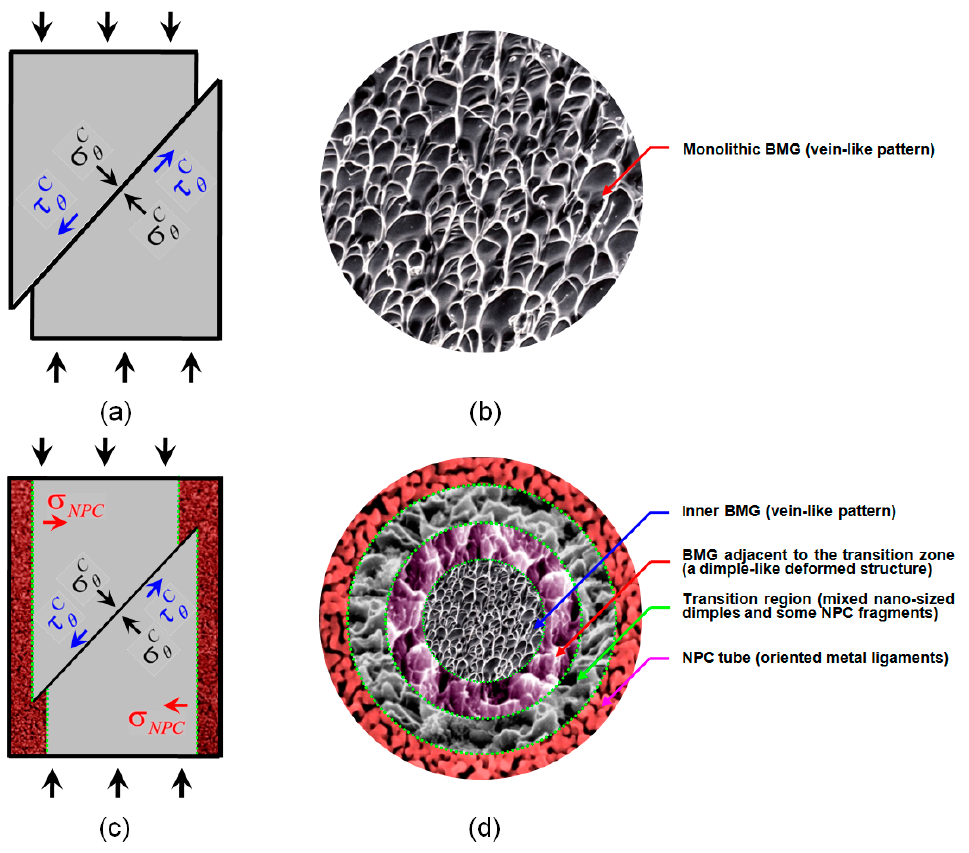
Figure 9. Illustration of the fracture deformation processes for ( a , b ) monolithic BMG and ( c , d ) NPC/BMG composite rods under applied load.